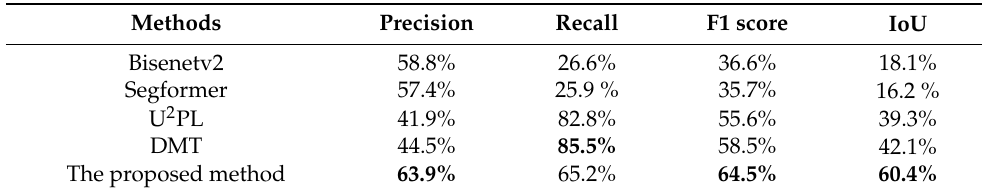
Figure 10. The monitoring results of five different methods for representative lands of Experiment 2: ( a ) original image; ( b ) Bisenetv2; ( c ) Segformer; ( d ) U 2 PL; ( e ) DMT; ( f ) the proposed method. The white, blue, and green pixels in ( b – f ) separately represent true positive, false positive, and false negative. Table 2. Quantitative evaluation results of Experiment 2. The entries in bold denote the best results in Experiment